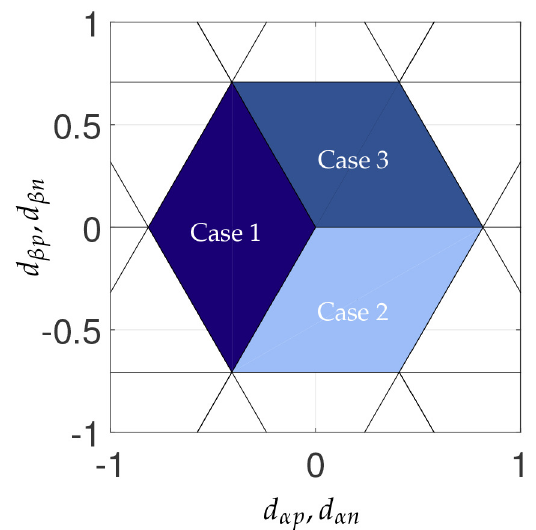
Figure 3. Graphical representation of the limits of each case.